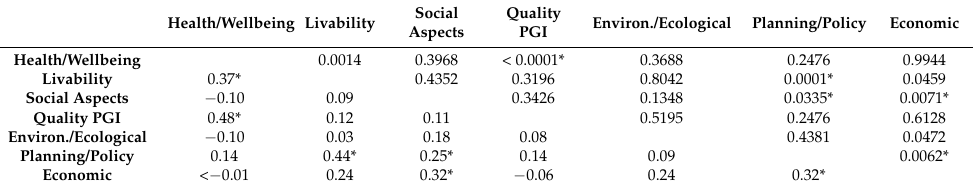
Table 5. Correlations (lower left) for research focuses reported in articles and p-values for significance of correlations (upper right). Significant correlations and the associated p-value are indicated by an